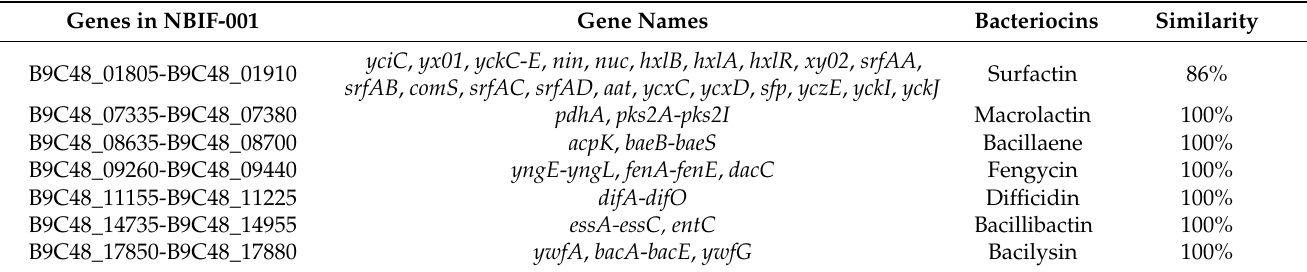
Table 4. Antibiotic-related genes in the NBIF-001 genome by